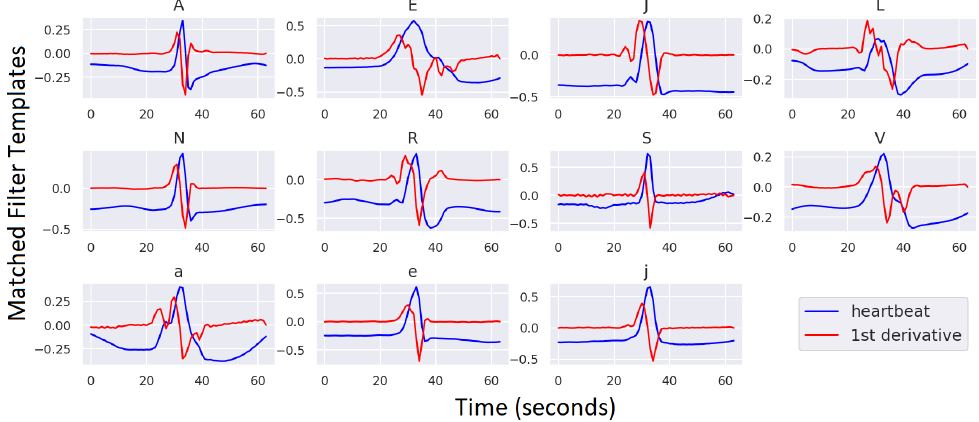
Figure 4. MF templates of the ECG heartbeat and its first derivative for all AAMI classes included in DS1 (excluding the “F” and “Q”